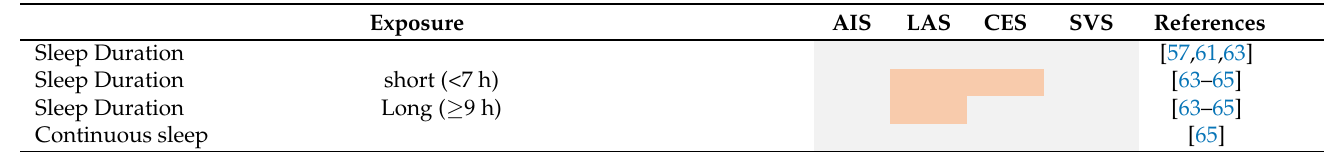
Table 2. Results from MR studies involving non-traditional stroke risk